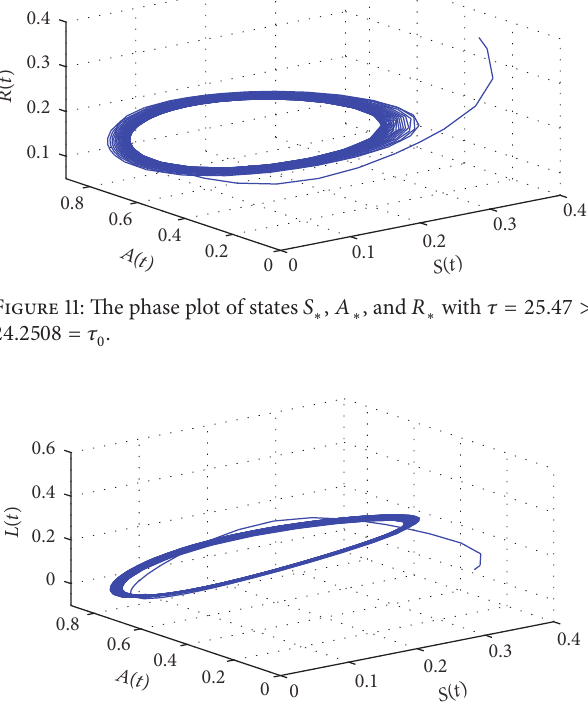
Figure 12: The phase plot of the states 𝑆 ∗ , 𝐿 ∗ , and 𝐴 ∗ with 𝜏 = 25.47 > 24.2508 = 𝜏